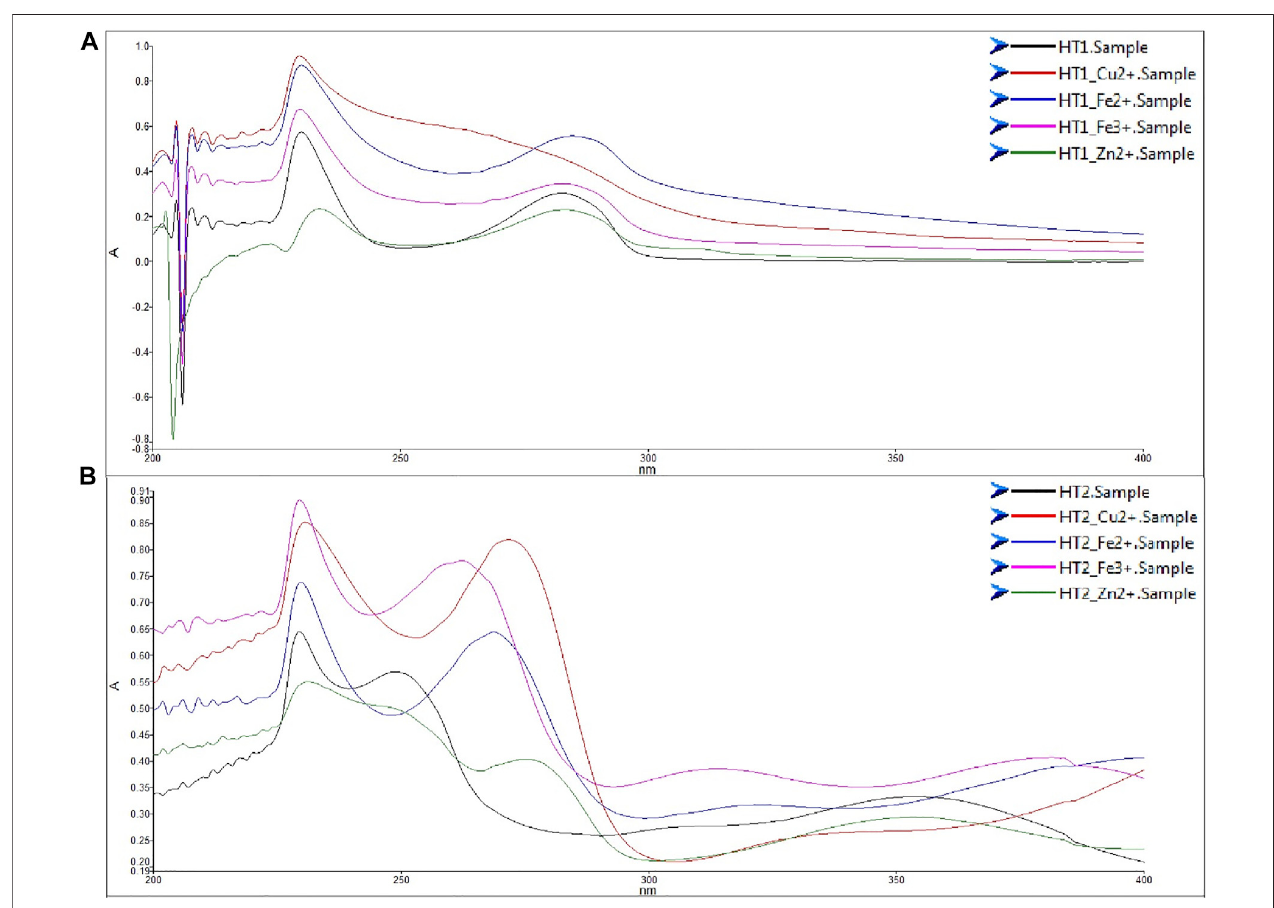
FIGURE3| Metalchelatingactivityofcompounds HT1(A) and HT2(B) .UVspectraofcompounds HT1 and HT2 UV-vis(200 – 400 nm)absorptionspectraofHT1 and HT2 (75 μ M) alone or with CuSO 4 (150 μ M), FeSO 4 (150 μ M), FeCl 3 (150 μ M), or ZnCl 2 (150 μ M), in MeOH.